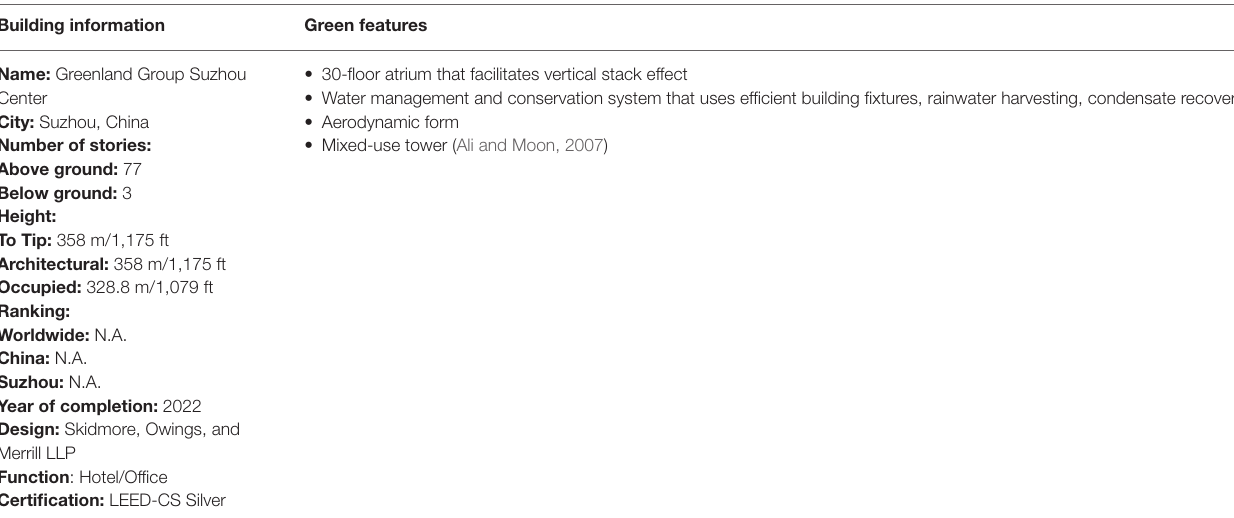
TABLE 10 | Greenland Group Suzhou Center: Key green features. Building